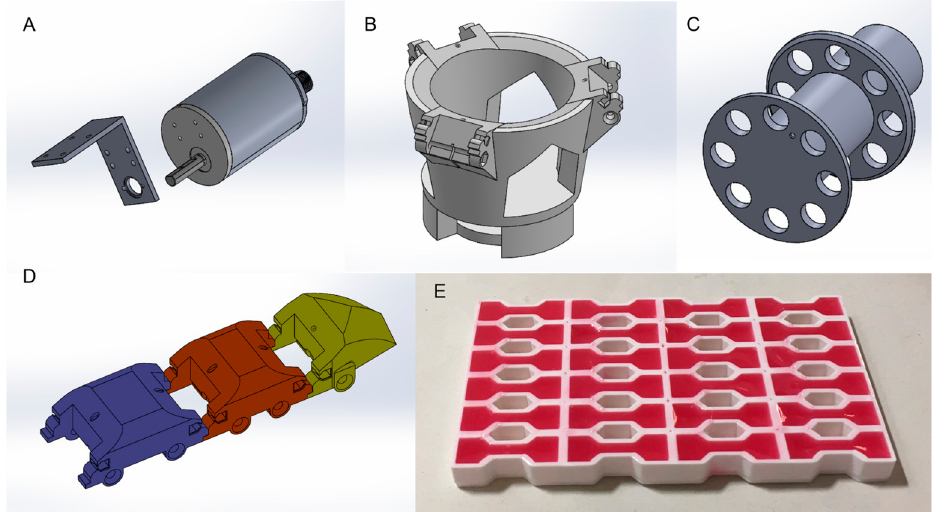
Figure 5. Components of the gripper. ( A ) Waterproof motor canister with attachment for the palm. ( B ) Hollow palm. ( C ) Pulley. ( D ) Finger made of three phalanges with slots for bow-tie joints, tendon, and springs. ( E ) Bow-tie joints before demolding.